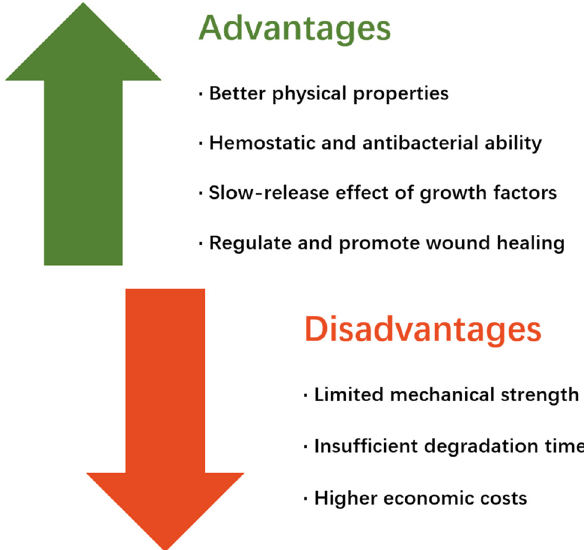
Figure 9: The advantages and disadvantages of the combination of natural - based biological hydrogels and growth factors for wound